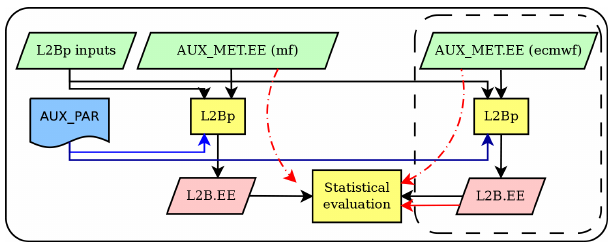
Figure 2. Flowchart of L2B generation and sensitivity study set- ups. The detailed description is given in Sect. 3. The EE stands for Earth Explorer file